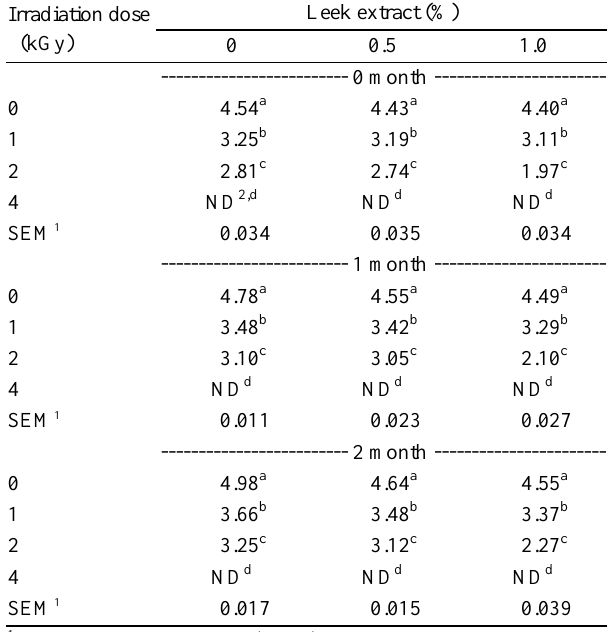
Table 2. Total aerobic bacterial counts (log CFU/g) of the electron beam irradiated pork jerky with added leek extract during storage for 2 months